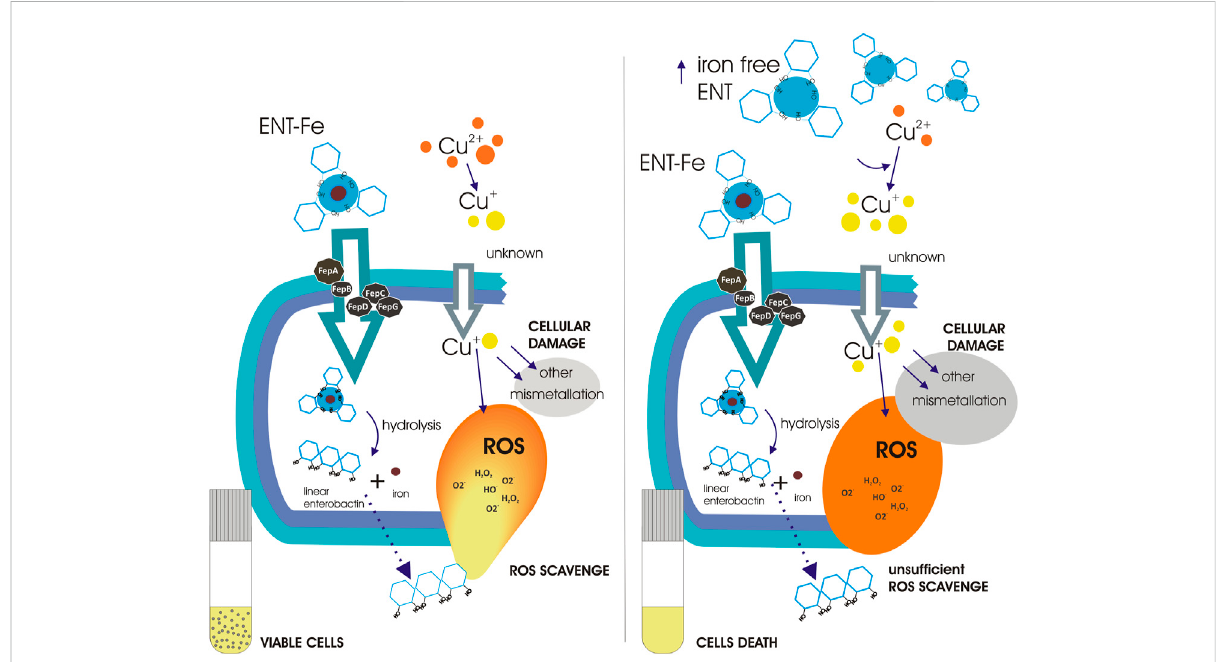
FIGURE 7 Schematic representation of the proposed role of enterobactin in copper tolerance and toxicity. Enterobactin enters cells as an iron- enterobactin complex. Uptake requires of the transport proteins FepA, FepB, FepC, FepD, and FepG. Once in the cytoplasm, the enterobactin-iron complex is hydrolyzed by Fes leaving enterobactin as a linear molecule, which is able to reduce ROS, and free iron for cellular metabolism. Linear enterobactin is possibly exported to the extracellular space of E. coli , where it would detoxify extracellular ROS, similarly as was recently reported for Salmonella (Bogomolnaya et al., 2020). Left panel shows that low enterobactin concentrations help cells to cope with copper-induced ROS. Even though, copper toxicity is multifaceted, enterobactin protection allows cells survival. Right panel when enterobactin is found in high concentrations, its ability to reduce Cu 2+ to Cu + enhances copper toxicity leading to cell death. The prevailing toxic mechanism of copper is unknown in this